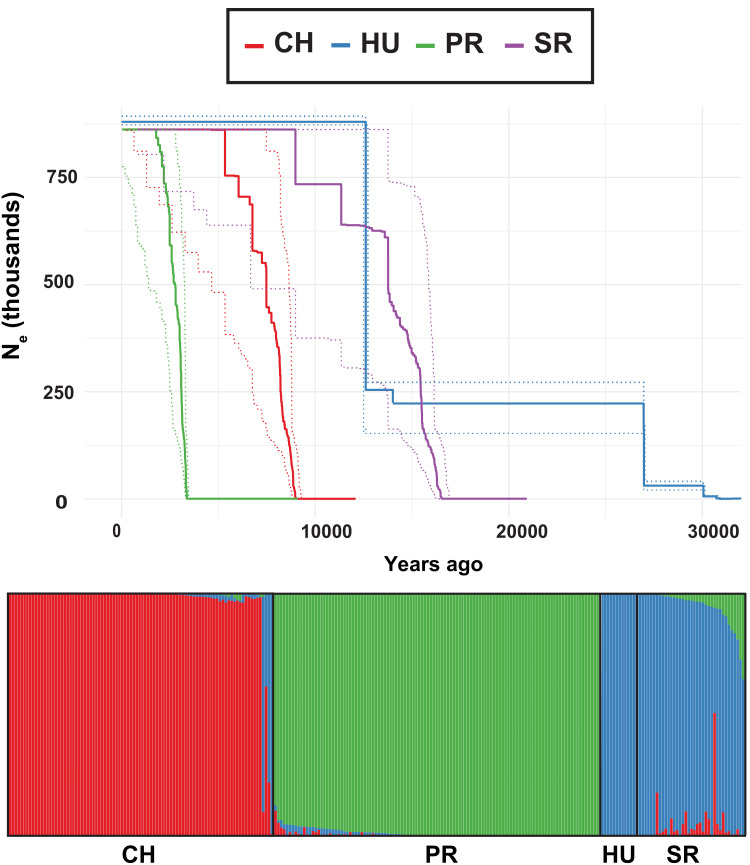
Effective population size backwards for each population of DiNV going backwards in time, estimated using StairwayPlot.Dotted lines indicate the error windows for Ne at a given time point. Lines are colored by population.